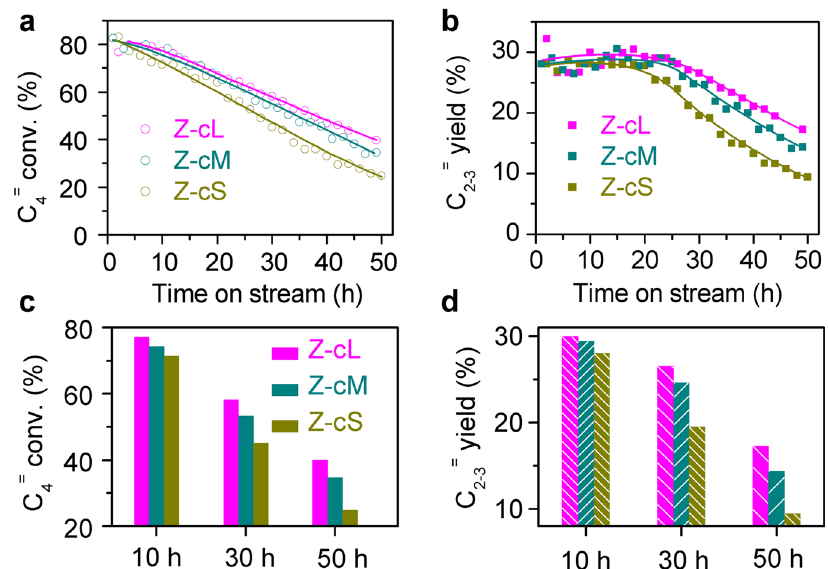
Fig. 3 Catalytic behaviors for C 4 ole fi n catalytic cracking reactions over Z-cS, Z-cM, and Z-cL catalysts. a C 4 = conversions. b Yields of propene and ethene. c , d detailed C 4 = conversions and C 2-3 = yields at different reaction times. Reaction conditions: M (catalyst) = 0.3 g; P = 1.6 bar; T = 823 K; F = 15 mLh − 1 ; time on stream, 50